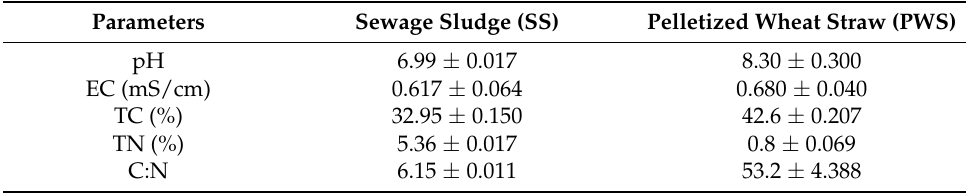
Table 1. Selected chemical properties of the sewage sludge and pelletized wheat straw. Parameters